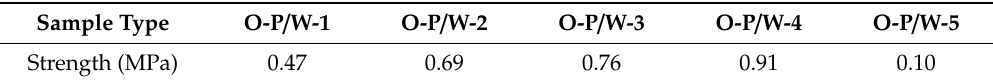
Table 2. Relationship between the W-OH concentration and the unconfined compressive strength of the original Pisha stone / W-OH